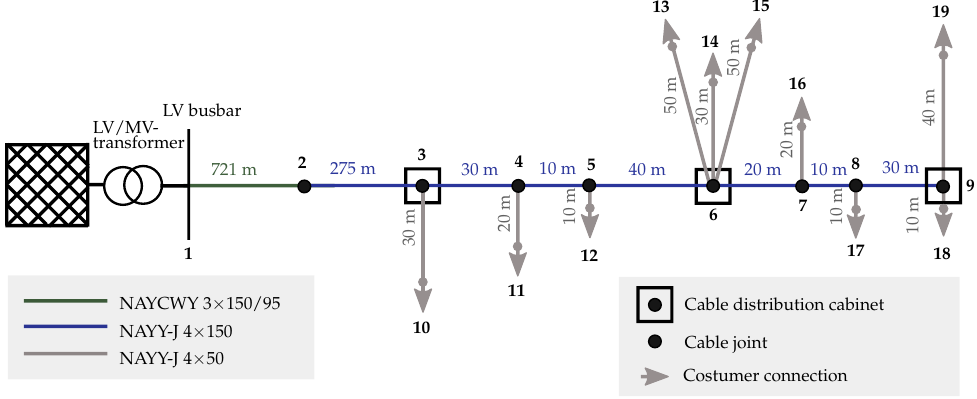
Figure 18. Sketch of test